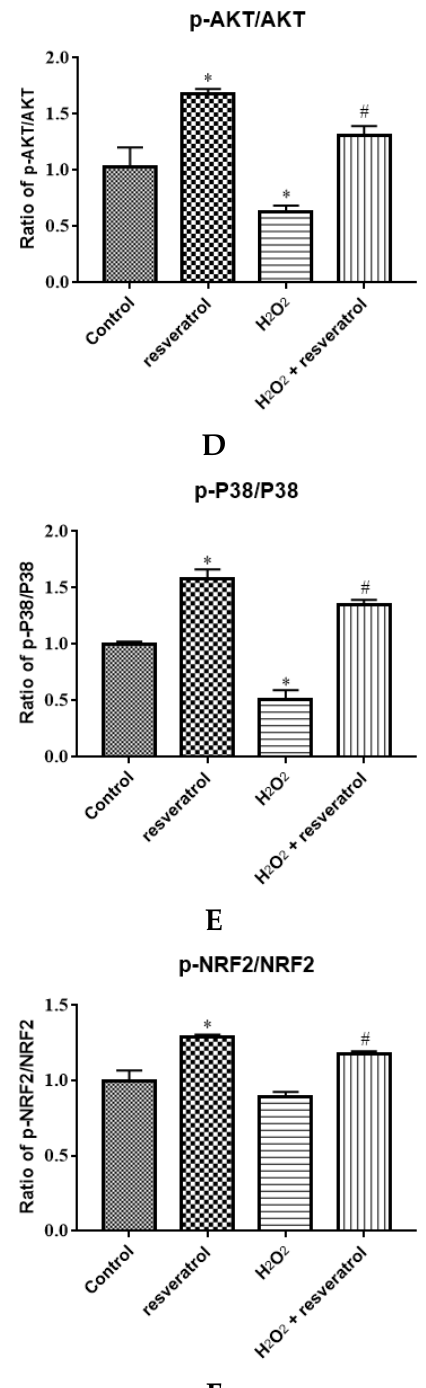
Figure 7. IDECs were pretreated with 5 µ M resveratrol for 6 h and then cocultured with 400 µ M H 2 O 2 for 6 h. ( A ) Protein levels of AKT, p-AKT, P38, p-P38, NRF2, p-NRF2, and GAPDH were detected by Western blot. ( B ) The expression of AKT, p-AKT, P38, and p-P38 was quantified by densitometry, and data were normalized to GAPDH. ( C ) The expression of NRF2 and p-NRF2 was quantified, and data were normalized to GAPDH. ( D ) Histogram of p-AKT/AKT in different treated IDECs. ( E ) Histogram of p-P38/P38 in different treated IDECs. ( F ) Histogram of p-NRF2/NRF2 in different treated IDECs. The data were analyzed through one-way ANOVA and are expressed as the mean ± SE ( n = 3). * p < 0.05 compared to control and # p < 0.05 compared to H 2 O 2 group. 3.7. Resveratrol Regulated the Expression Levels of Apoptosis-Related Proteins in H 2 O 2 -Induced IDECs To clarify the role of resveratrol in the apoptosis of IDECs, the expression levels of apoptosis-related proteins such as Bax, Bcl-2, caspase-3, cleaved caspase-3, caspase-9, and cleaved caspase-9 were detected by Western blot. There was a marked increase in the expression levels of cleaved caspase-3 and cleaved caspase-9 after H 2 O 2 treatment compared with the control group ( p < 0.05), whereas resveratrol treatment significantly inhibited the increase in the levels of these two proteins ( p < 0.05) (Figure 8A-B). The